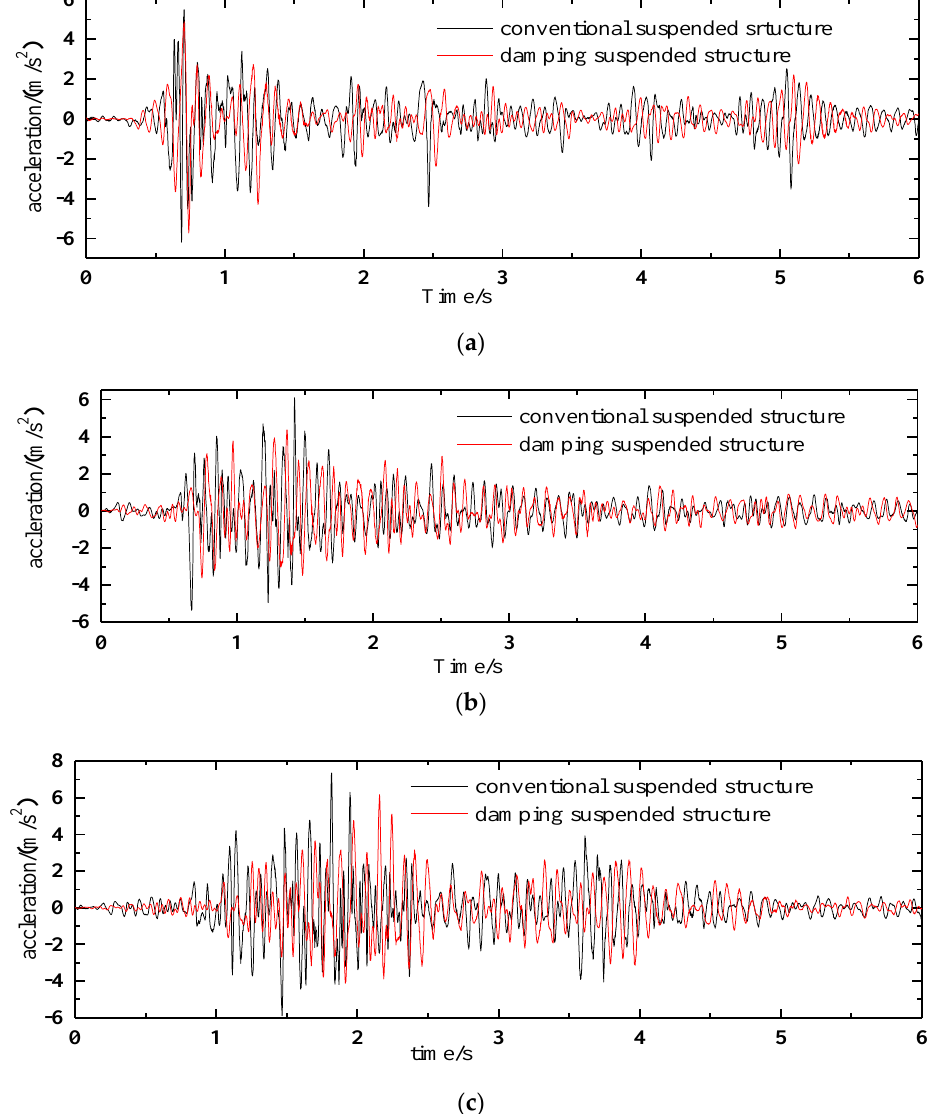
Figure 9. Acceleration time history curves at top of primary structure under 9 frequent earthquake. ( a ) Acceleration time history under El Centro; ( b ) Acceleration time history under Taft; ( c ) Acceleration time history under artificial wave.